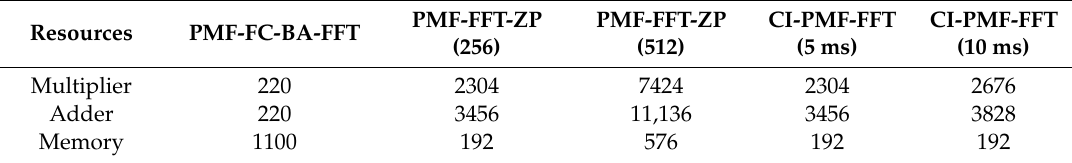
Table 4. Extra computational